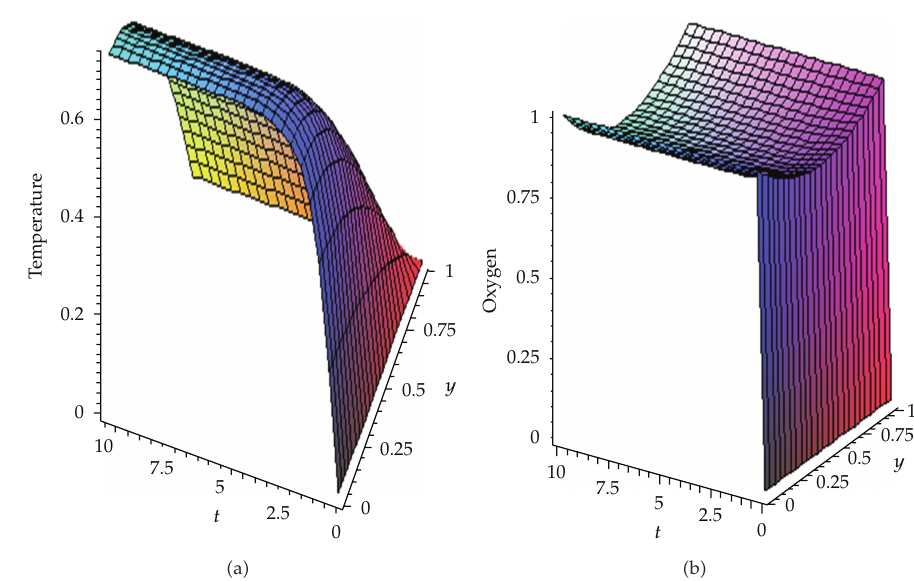
Figure 4: Temperature and oxygen concentration profiles for m (cid:8) 0 . 5, n (cid:8) 2, α (cid:8) β (cid:8) λ (cid:8) 1 , θ w (cid:8) 0 , ε (cid:8) 0 . 1.